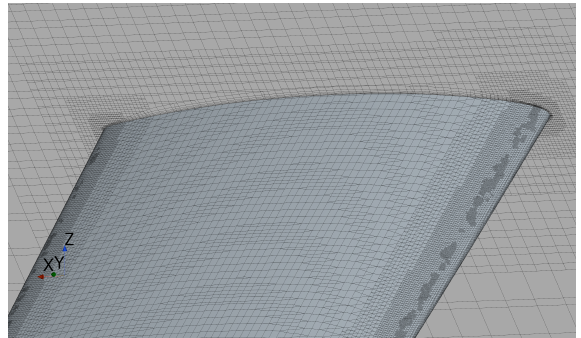
Figure 21. The structure of the mesh around the Z-foil showing a plane intersecting the span where the refinement regions at the leading and trailing edges are shown, as well as the boundary layer